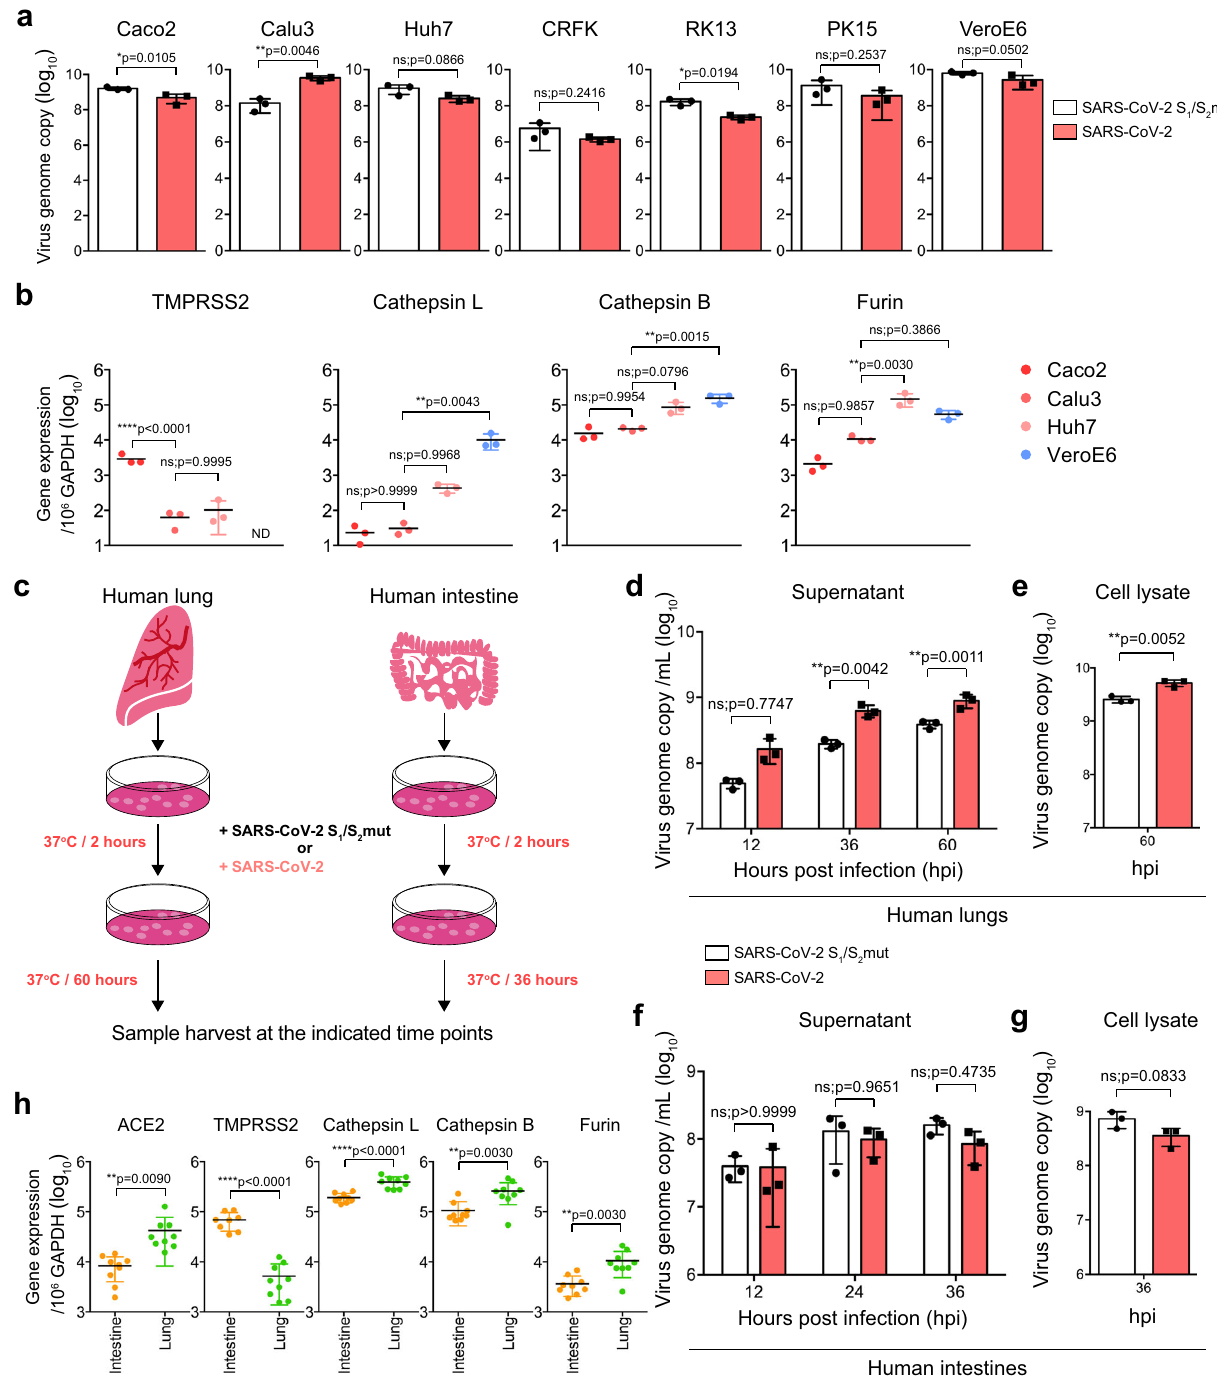
Fig. 6 The furin-like cleavage site in SARS-CoV-2 spike is required for ef fi cient SARS-CoV-2 replication in human lungs. a Seven cell types of human and non-human origin, including Caco2 (human intestine), Calu3 (human lung), Huh7 (human liver), CRFK (cat), RK13 (rabbit), PK15 (pig), and VeroE6 (monkey) were infected with SARS-CoV-2 or SARS-CoV-2 S 1 /S 2 mut at 0.2 MOI. Cell lysates were collected at 24hpi for viral genome copy analysis by qRT-PCR ( n = 3). b The expression of TMPRSS2, cathepsin L, cathepsin B, and furin from Caco2, Calu3, Huh7, and VeroE6 were analyzed with qRT-PCR ( n = 3). c Schematic of ex vivo human lung and intestinal tissue infection. d – g Human lung and intestine tissues were infected with SARS-CoV-2 or SARS- CoV-2 S 1 /S 2 mut. Cell lysate and supernatant samples were harvested at the indicated time points for qRT-PCR analysis ( n = 3). h The expression of ACE2, TMPRSS2, cathepsin L, cathepsin B, and furin from human lung and intestinal tissues were determined with qRT-PCR ( n = 8 for TMPRSS2 in intestine and n = 9 for other groups). Data represented mean and standard deviations from the indicated number of biological repeats. Statistical signi fi cance between groups was determined with two way-ANOVA ( d and f ), one way-ANOVA ( b ), or two-sided unpaired Student ’ s t test ( a , e , g , and h ). * represented p < 0.05, ** represented p < 0.01, *** represented p < 0.001, **** represented p < 0.0001. ns not signi fi cant. Source data are provided as a Source Data fi le.